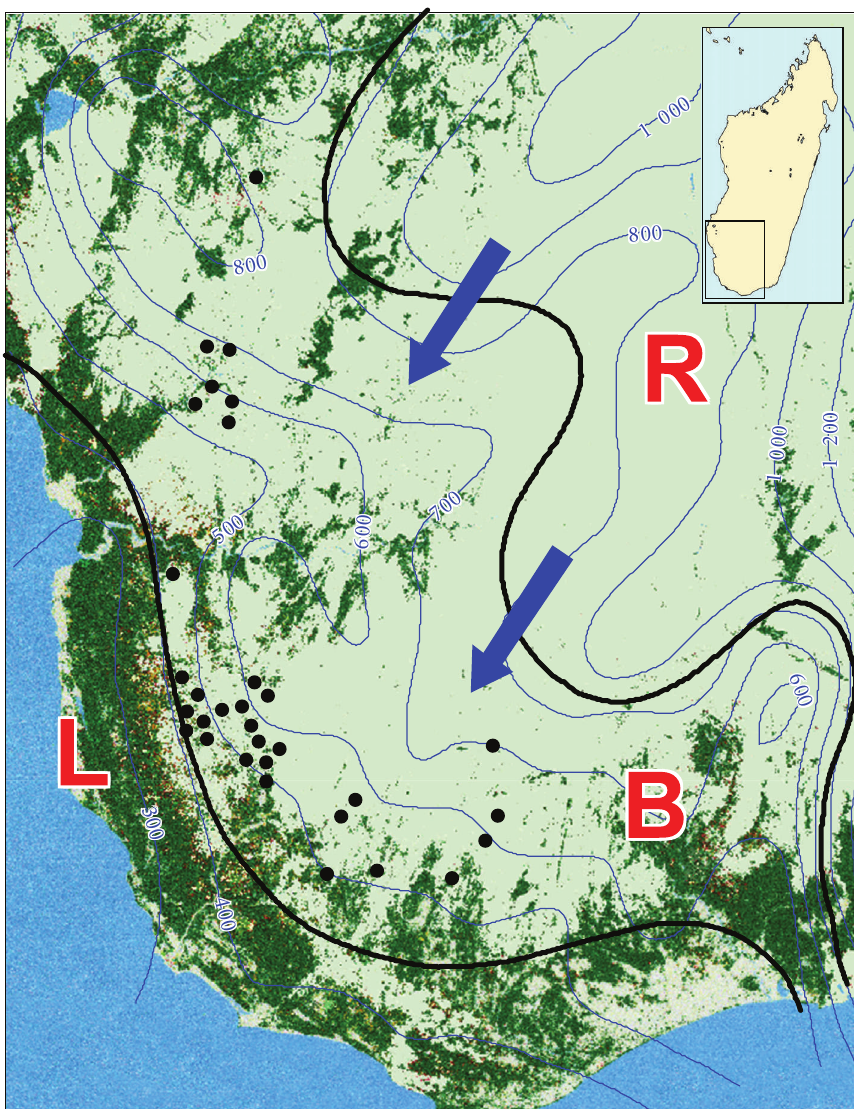
Figure 2: Location of the locust hoppers sampling sites in 2007 and 2008 in southern Madagascar. R: dry season refuge zone; B: breeding zone; L: unsuitable southernmost border zone. Green areas: dry forest. Blue lines: isohyets (mm). The arrows underline the orientation of the migrations of maturing adult populations at the beginning of rain season (according to Lecoq et al.